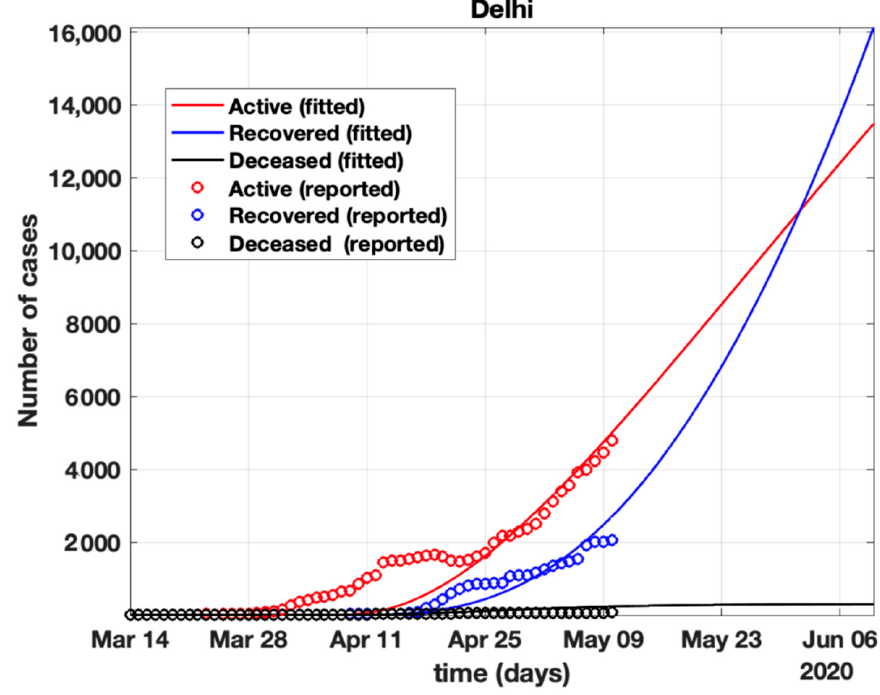
Figure 16. Fit of the proposed model (1) for the number of COVID-19 cases in Delhi.